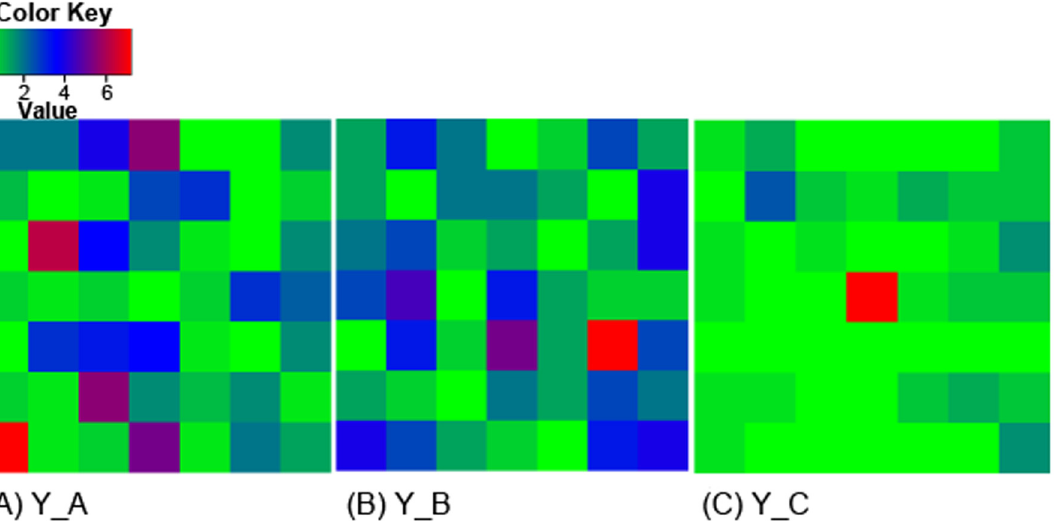
Fig 2. Spatial pattern of Verticillium dahliae inoculum in quadrats. The inoculum density (CFU g -1 of soil) of V . dahliae were estimated in three commercial cotton fields (Y_A, Y_B, and Y_C) using the wet-sieving plating method. Within each field, the sampling plot was divided into 49 (7 × 7) quadrats of the 1.2 m × 1.2 m size. Within each quadrat, a single core (ca. 2.5 cm in diameter) sample of soil (at depth 0 – 20 cm) was sampled in late August at each of five points: near the four corners and the quadrat centre point; these five samples were then mixed together, resulting in a single composite sample for each